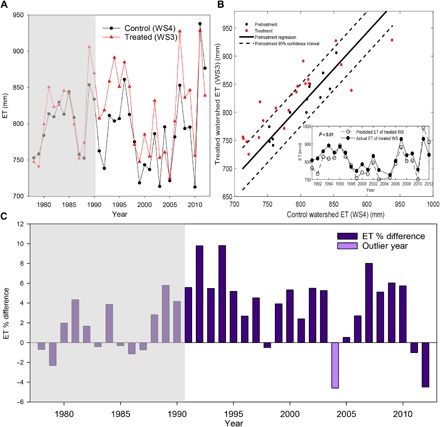
ET dynamics on the control and treatment watersheds during the pretreatment and treatment periods.(A) Annual ET estimates for both the control (black) and treatment (red) watersheds. The area in the grayed out boxes represents the pretreatment period (1978–1990). (B) Comparison of the control and treatment watersheds during the pretreatment and treatment periods and the relationship between observed ET and predicted ET (based on the pretreatment relationship) for the treatment watershed during the treatment period (inset). (C) Percent ET difference between the control and treatment watersheds.